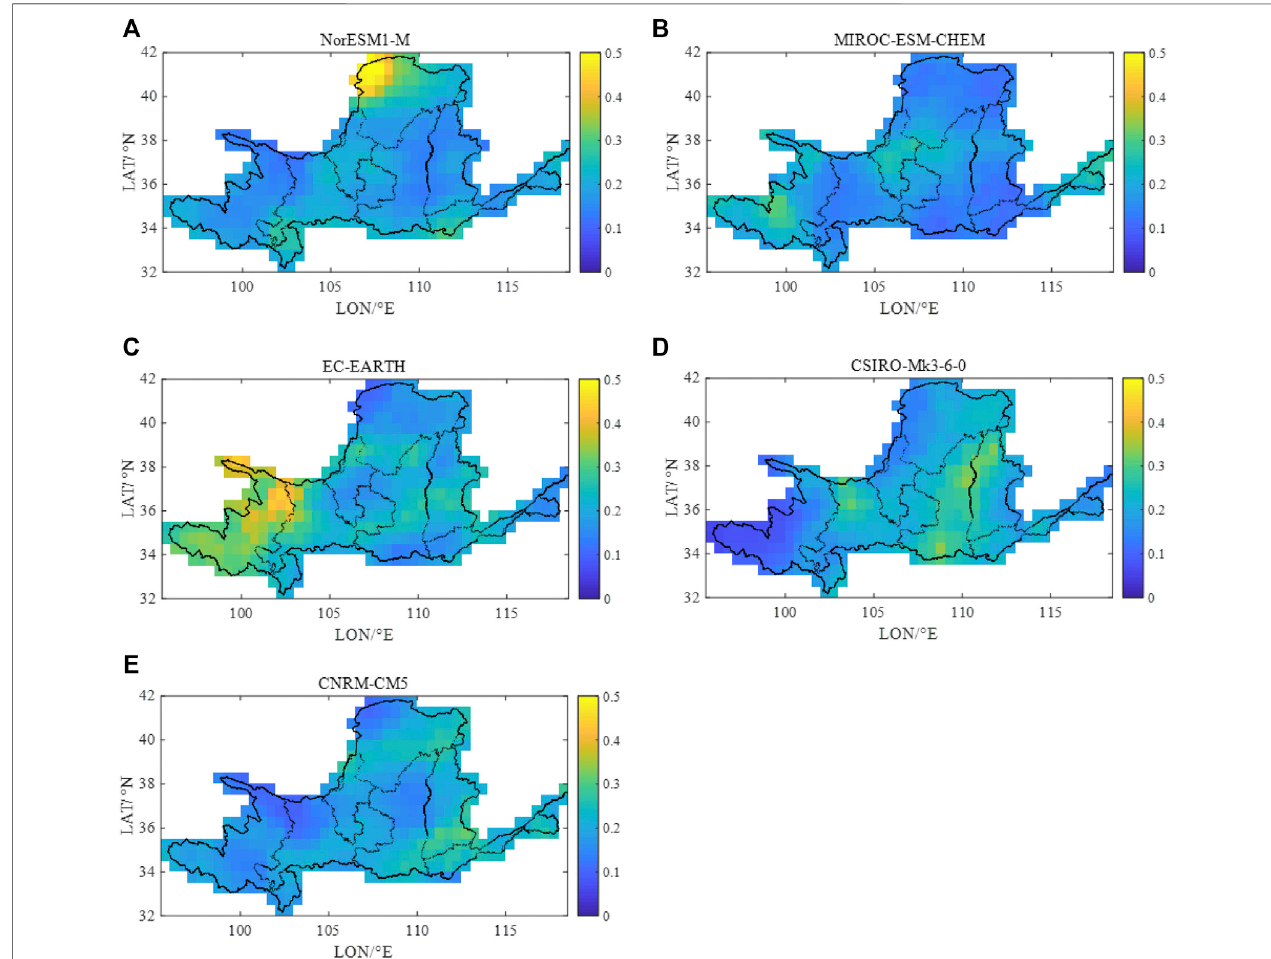
FIGURE 7 | Weights on each grid of the fi ve CMIP5 models from grid-based BMA. (A – E) represents fi ve CMIP5 models of (A) NorESM1-M, (B) MIROC-ESM- CHEM, (C) EC-EARTH, (D) CSIRO-Mk3-6-0, (E) CNRM-CM5.